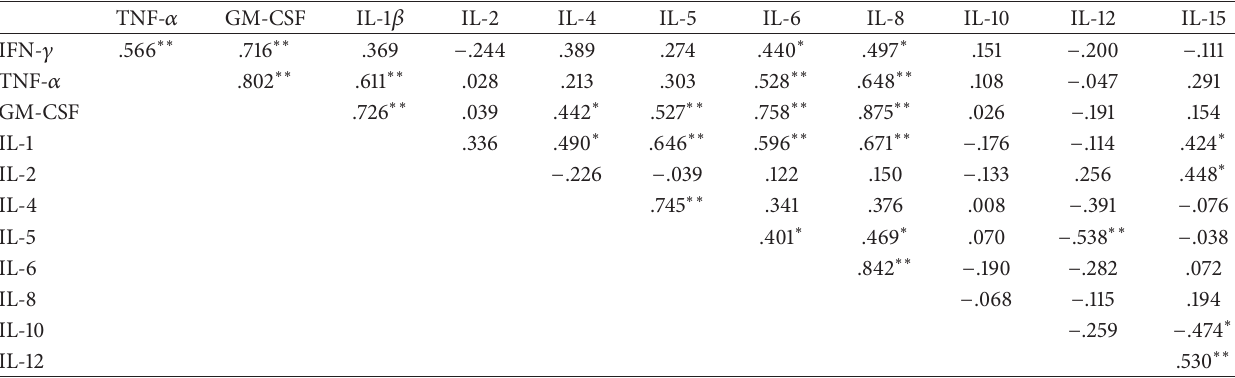
Table 4: Relationship between the serum levels of cytokines in children with tuberculous lymphadenitis ( 𝑛 = 25 ) based on Spearman’s rank correlation. The values shown are the correlation coefficients.